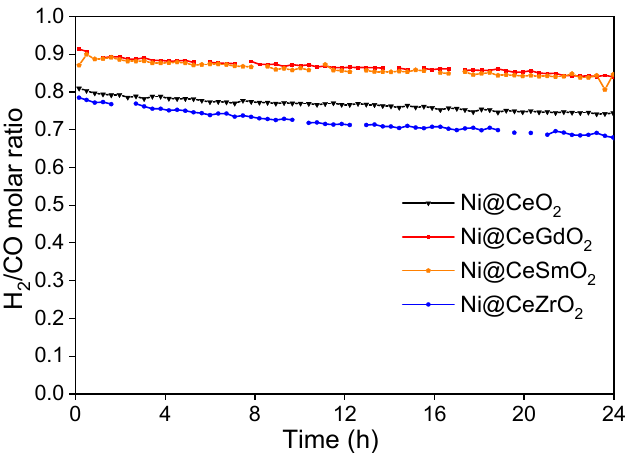
Figure 9. H 2 /CO molar ratio obtained in the the DRM at 800 °C as a function of TOS (CH 4 /CO 2 molar ratio of 1.0; W/F = 0.2 g cat · L − 1 h − 1 ).